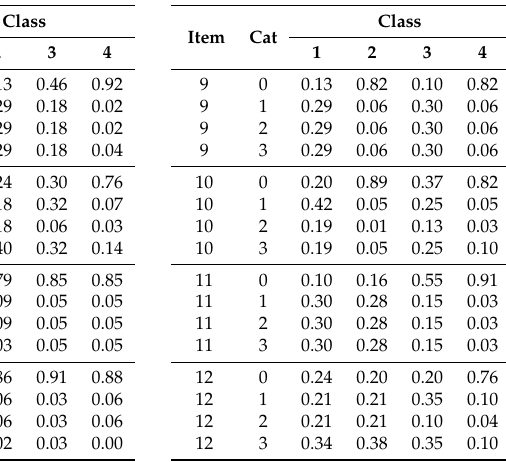
Table 8. Data illustration polytomous data: estimated item response probabilities in the RLCM with C = 4 classes and fused regularization among classes based on the minimal